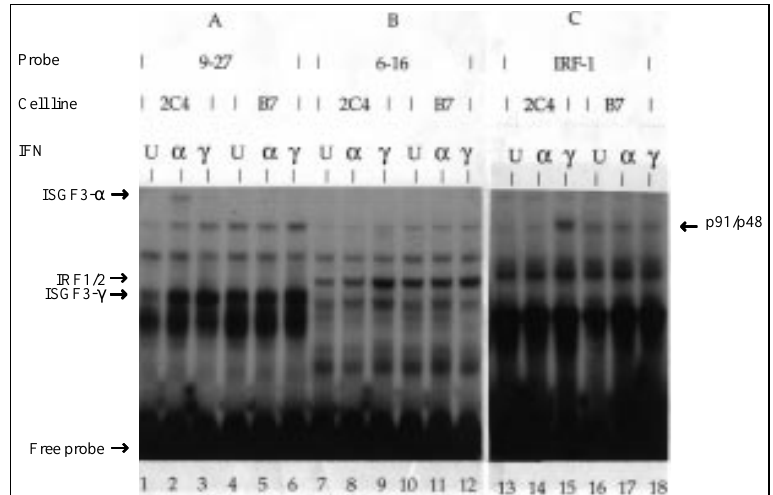
Figure 3 - IFN-activated transcriptional complex formation. EMSA of ISGF3- a , ISGF3- g , IRF1/ 2 and p91/p48 in whole cell extracts from IFN-treated 2C4 and B7 cells. Cells were left untreated (U) or treated with 500 IU/ml of either IFN- a or IFN- g for 6 h and 18 h, respectively. Cell extracts were incubated with an end-labelled oligodeoxynucleotide probe containing the promoter region of 9-27 (A, lanes 1-6); 6-16 (B, lanes 7-12) or IRF-1 (C, lanes 13-18) genes. DNA-protein complexes formed are